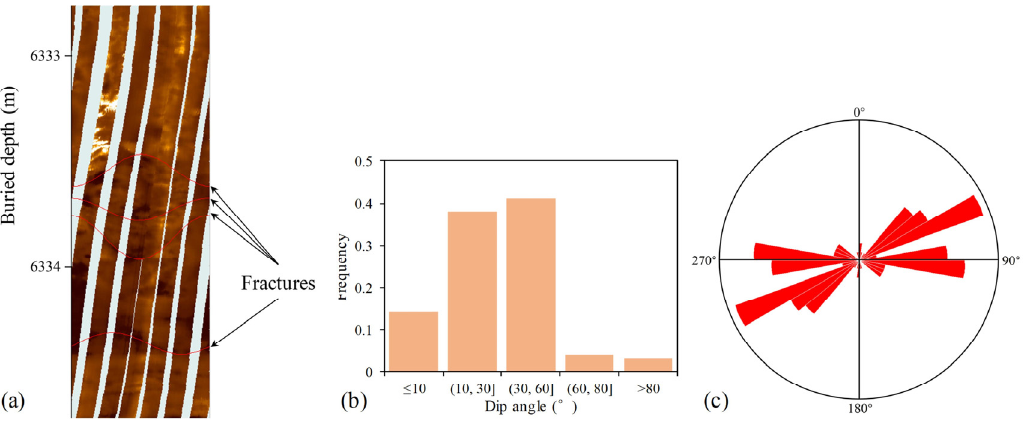
Figure 12. ( a ) Image-logging of well PZ1, ( b ) statistical results of fracture dip angle, and ( c ) rose diagram of fracture strike in the T 2 l 4 Formation.